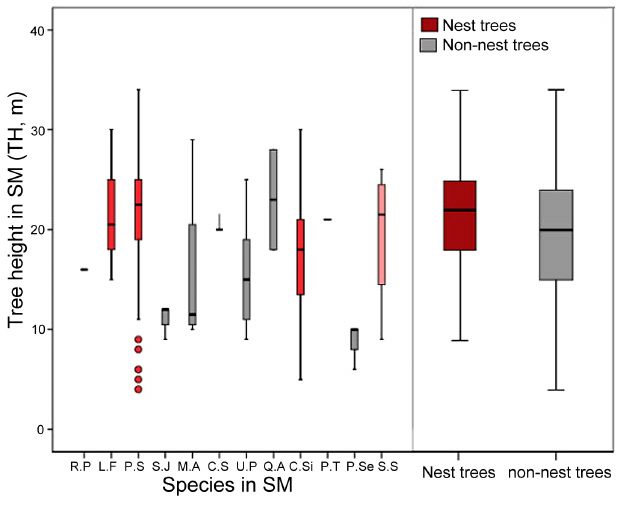
Fig. 3 . Comparison of tree height of nest trees and non-nest trees in Shimen (SM). Note: Red bars indicate nesting trees, gray bars indicate non-nest trees, and the error bars indicate standard error. R.P = Robinia pseudoacacia Linn., L.F = Liquidambar formosana , P.S = Pterocarya stenoptera , S.J = Sophora japonica Linn., M.A = Melia azedarach Linn., C.S = Castanopsis sclerophylla, U.P = Ulmus parvifolia Jacq., Q.A = Quercus acutissima Carruth., C.Si = Celtis sinensis Pers., P.T = Pteroceltis tatarinowii Maxim., P.Se = Pyrus serotina , S.S = Sapium sebiferum . The tree height of nesting trees and non-nest trees are significantly different (F1,224 = 12.4, p =